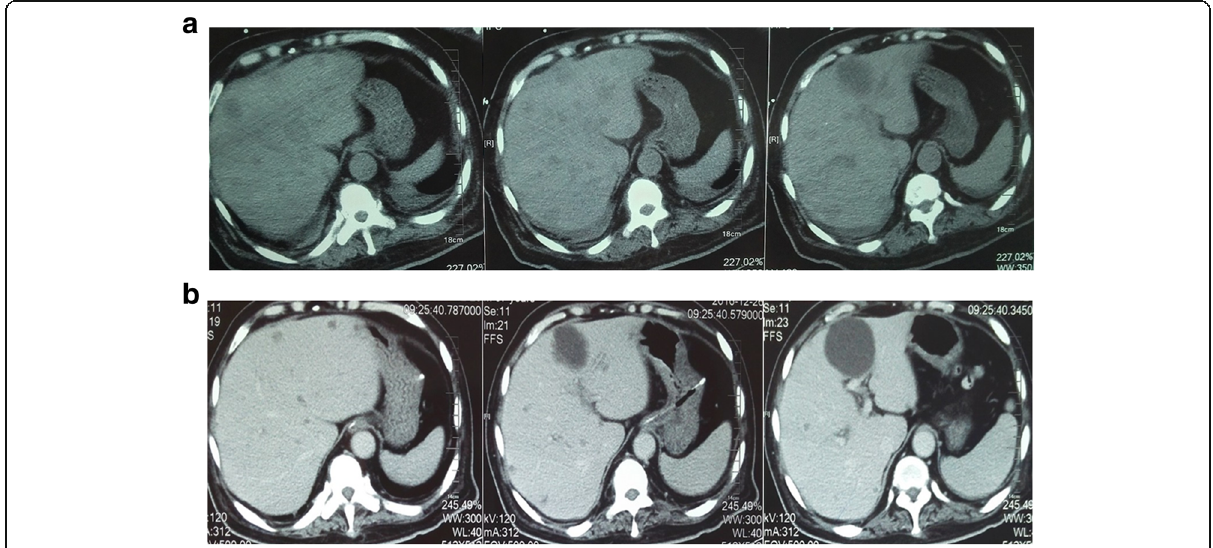
Fig. 2 Shrinkage of the patient ’ s intra-hepatic lesions after two months of olaparib treatment. CT scan of the abdomen before ( a ) and after ( b